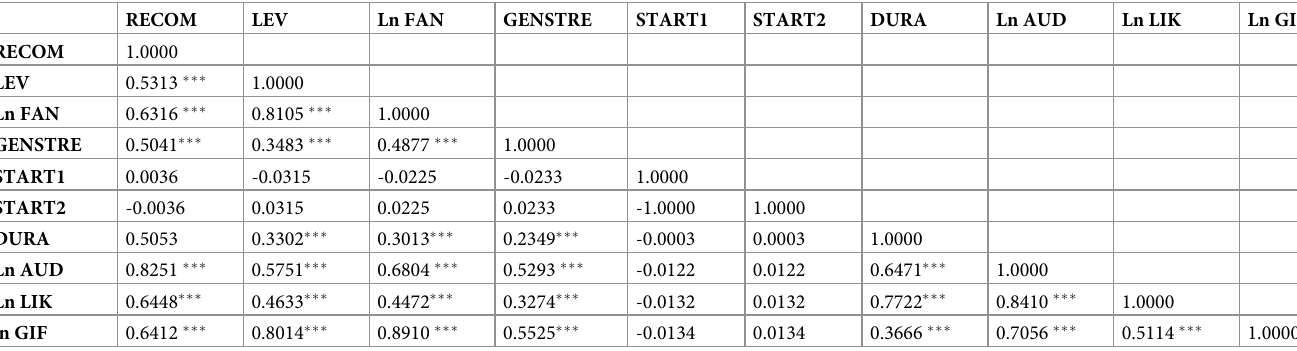
Table 4. Correlations among the logarithmic